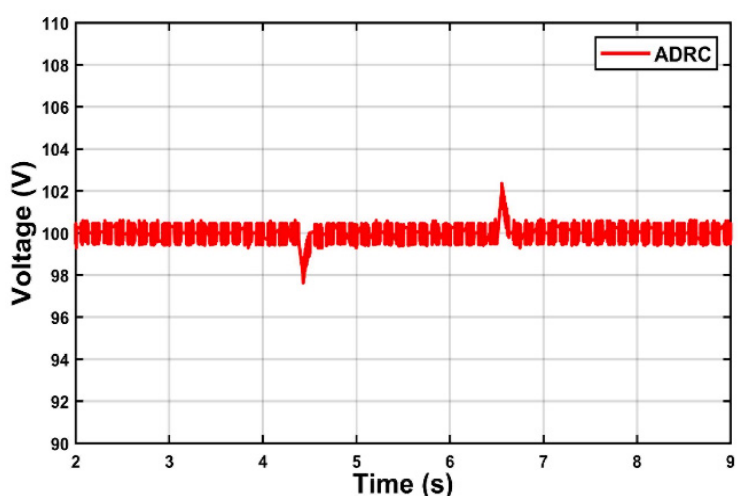
Figure 15. Output voltage response.